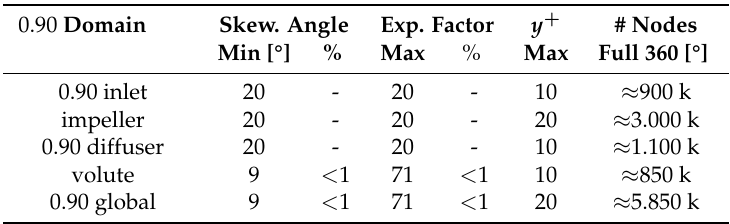
Table 1. Mesh size and